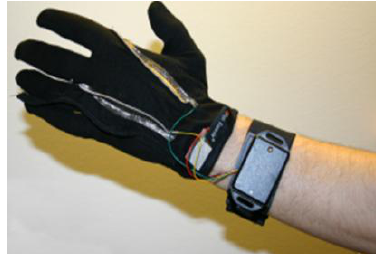
Figure 5. Sensorized glove connected to the measuring unit fasten to the